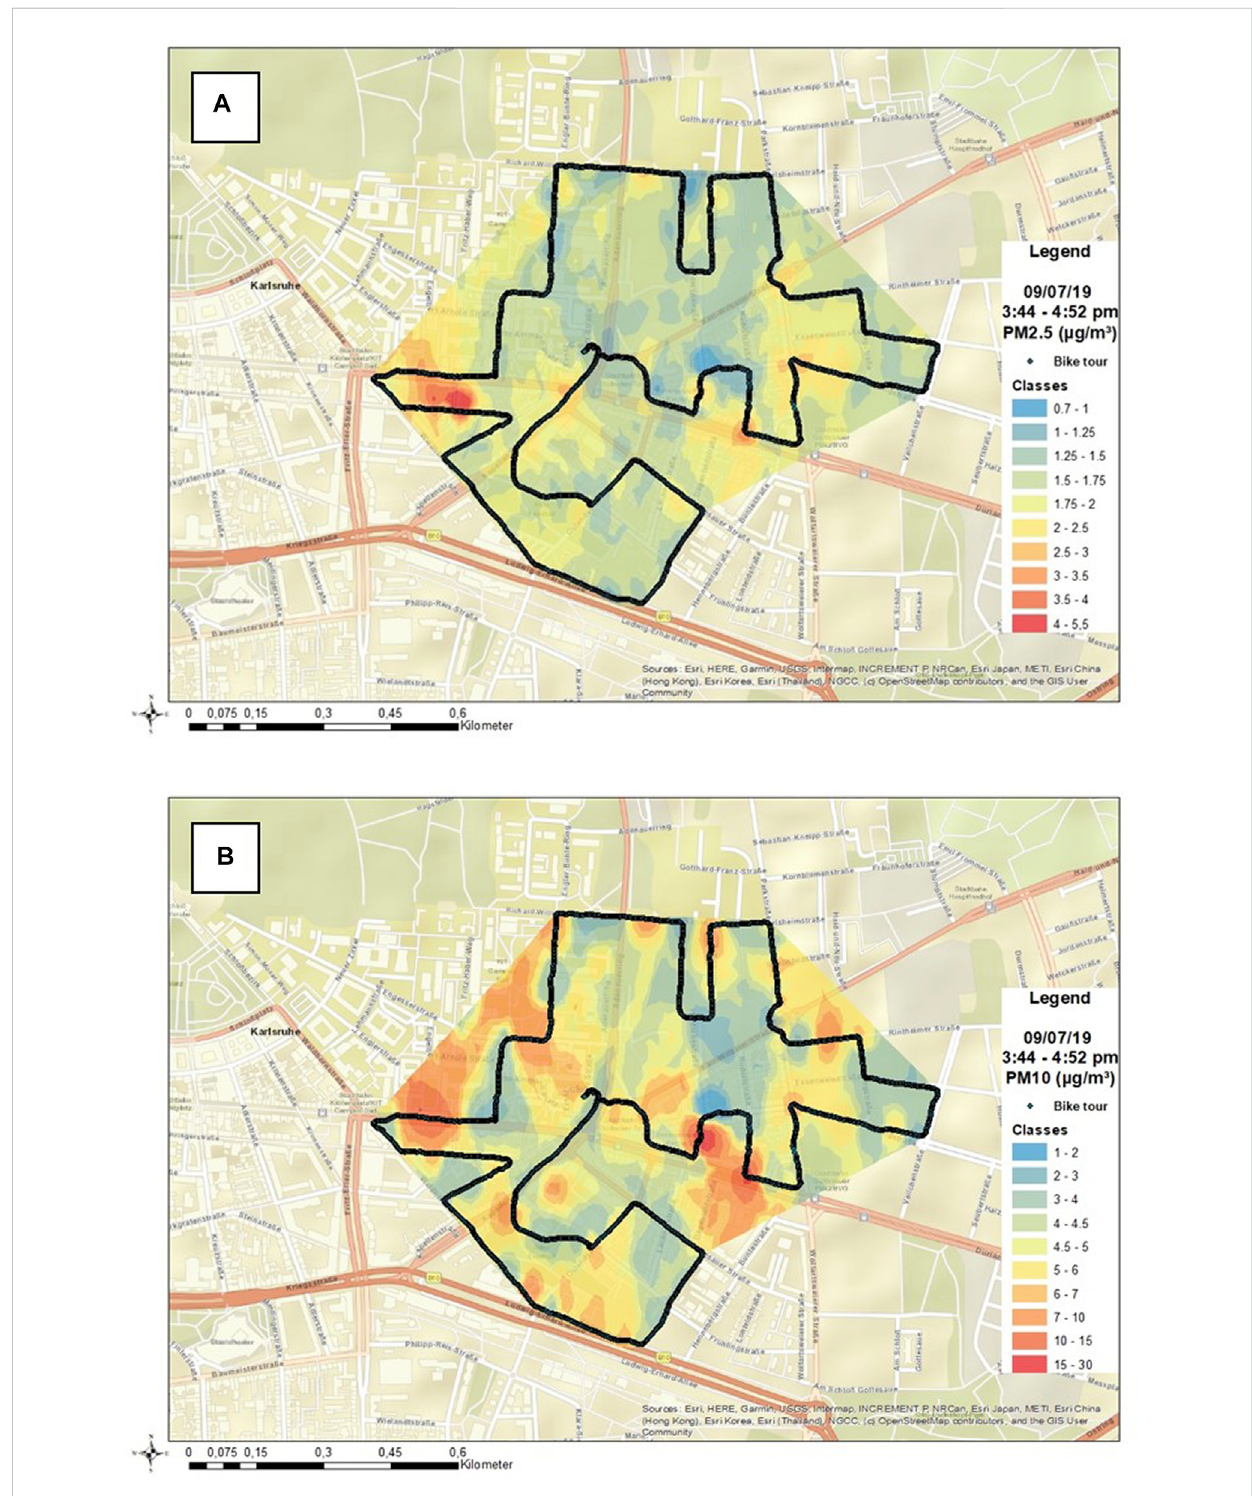
FIGURE 8 (A) PM 2.5 concentration pattern on 9th of July 2019, 3:44